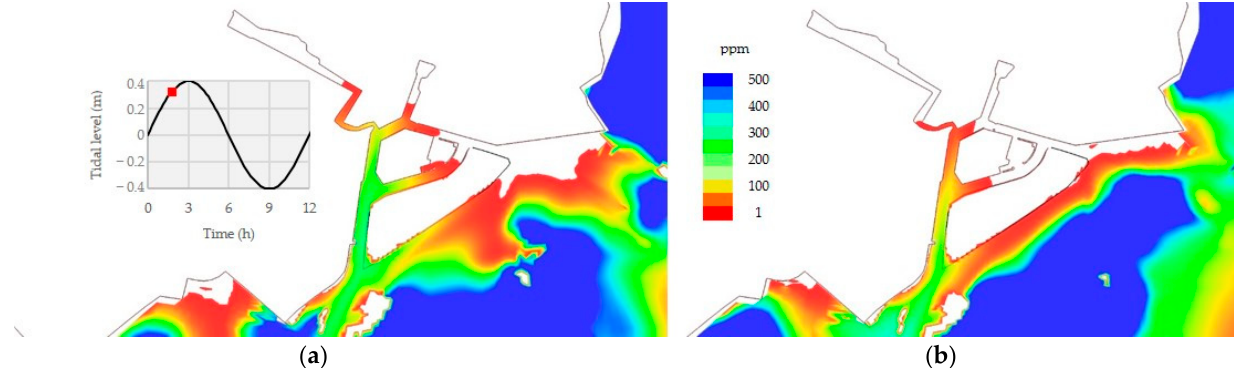
Figure 10. Contour of the maximum suspended sediment concentration during the flood tide: ( a ) Bora simulation; ( b ) Sirocco simulation.